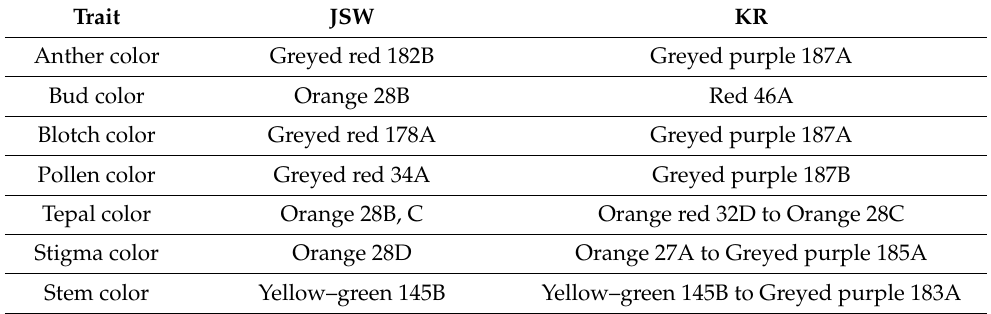
Figure 3. Comparison of KR and JSW L. leichtlinii . ( a ). Plant height of representative KR and JSW L. leichtlinii in germplasm field. ( b ). Bud morphology. ( c ). Stem color and hairs on the shoots and flower bud. ( d ). Anther color of JSW ( a ) and KR ( b ) plants. ( e ). Stigma color of JSW (#1) and KR plants (#2-4). ( f ). Flower morphology. ( g ). Fruit size. ( h ). Size of fully developed stolons. Scale bar of b , c , and f = 2 cm; d , e , and g = 1cm. Table 3. Comparison of qualitative traits between JSW and KR L. leichtlinii (N =